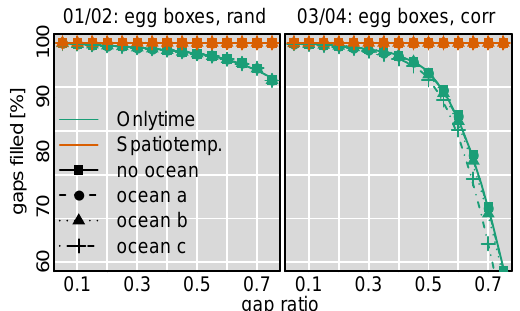
Fig. 8. Percentage of non-filled gaps for the different test scenar- ios. Solid or dashed lines were obtained using a loess smoother for each scenario and dataset. Comparable for scenario 12–16 would be identical to the “correlated” gaps figure as they have identical gap